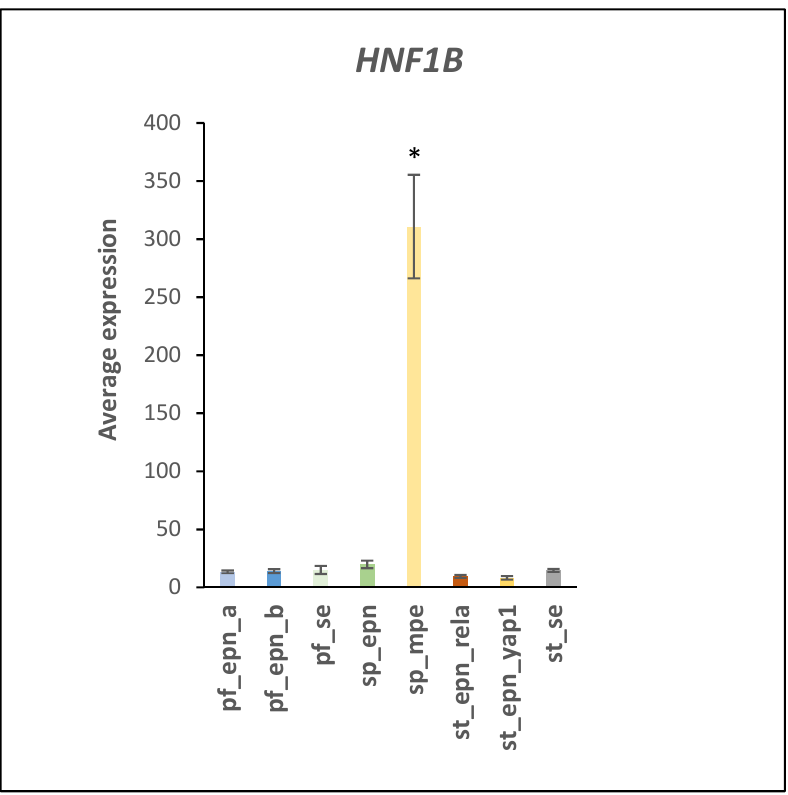
Figure 9. Gene encoding stem cell marker and cell adhesion factor, L1CAM , overexpressed in ST_EPN_RELA (by Anova, F = 173.55, p = 1.35 × 10 − 81 ). * significantly different from all other groups at p < 0.001. Dataset GSE64415.